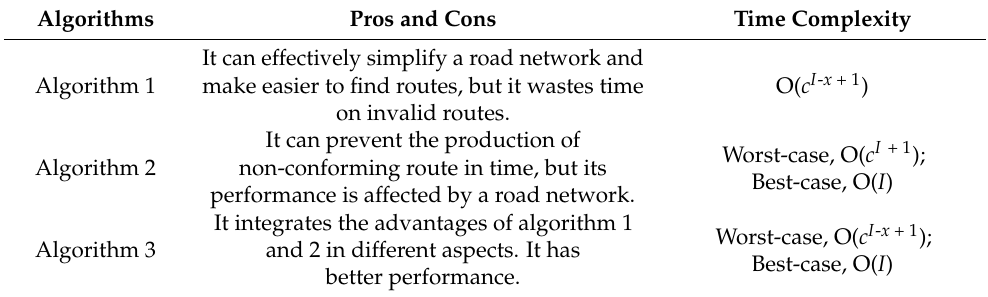
Table 5. Pros and Cons of Three